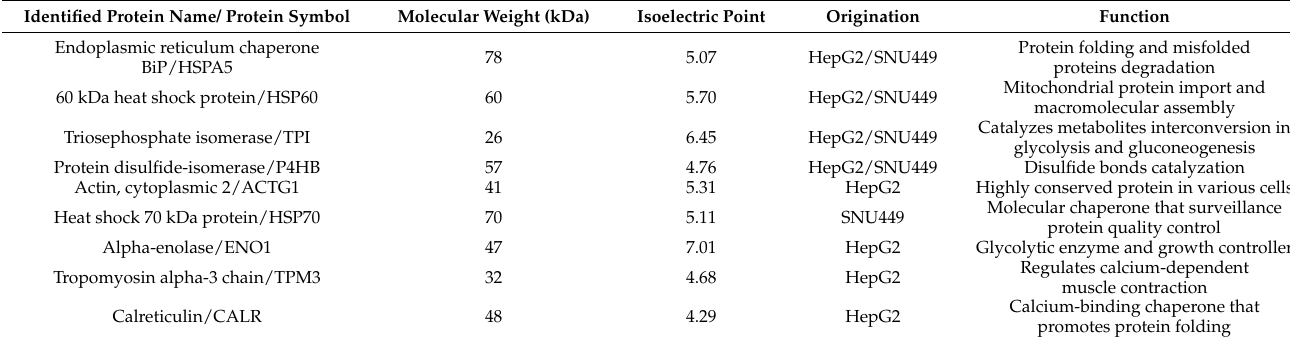
Table 1. Nine potential TAA targets identified by SERPA.